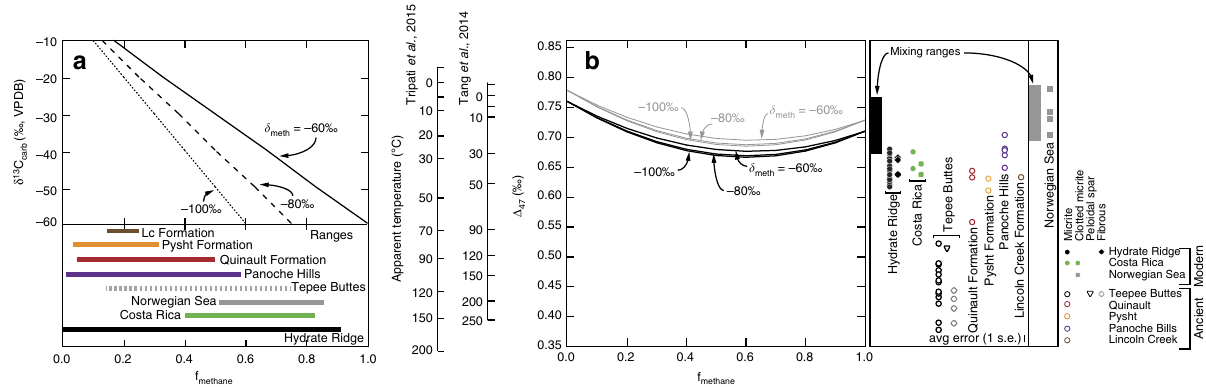
Figure 7 | Comparison of clumped isotope compositions with mixing-related temperature anomalies. ( a ) Diagram depicting the fractional contribution of methane-derived carbon (f methane ) based on d 13 C carb values and a range of methane carbon isotope compositions ( d meth ). Here, f methane is calculated assuming that carbon is derived from methane and seawater (with d 13 C ¼ 0). Ranges of f methane arise from variable d 13 C carb and hypothetical d meth values. Notice how modern and most ancient seep carbonate d 13 C carb values overlap with those required for a 50:50 mixture (that is, f methane ¼ 0.5). ( b ) Results of mixing between two environmentally constrained end-members as calculated using the approach of Defliese et al. 65 . Grey envelope and curves correspond to the potential range of values resulting from mixing in Norwegian Sea carbonates. Black envelope and curves correspond to all others. See text for information concerning end-member isotope compositions. Notice that mixing cannot account for the clumped isotope and temperature anomalies recorded in cold seep carbonates, both the Tripati et al. 40 and Tang et al. 41 calibration-derived temperatures included. Note that dolomites of the Eel River Basin are not included in this diagram. This is because positive d 13 C carb values indicate formation in the zone of methanogenesis and therefore potential mixing cannot be independently assessed as with the other